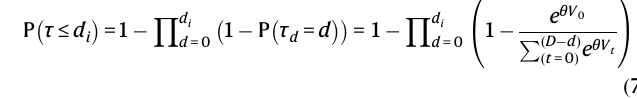
Fig. 5 | Explaining procrastination with neural correlates of time preferences. a Statistical parametric maps (SPM) of delay (chosen minus unchosen delay), – (undiscounted) reward value and + (undiscounted) effort cost, and the conjunction between the two regressors, at the time of deliberation. b Correlation between behavioral and neural estimates of the weight on delay (temporal discount rates in choice model versus delay regression estimates in dmPFC activity). Source data are provided as a Source Data fi le. c Regression estimates of beta weights on dmPFC activity for delay and